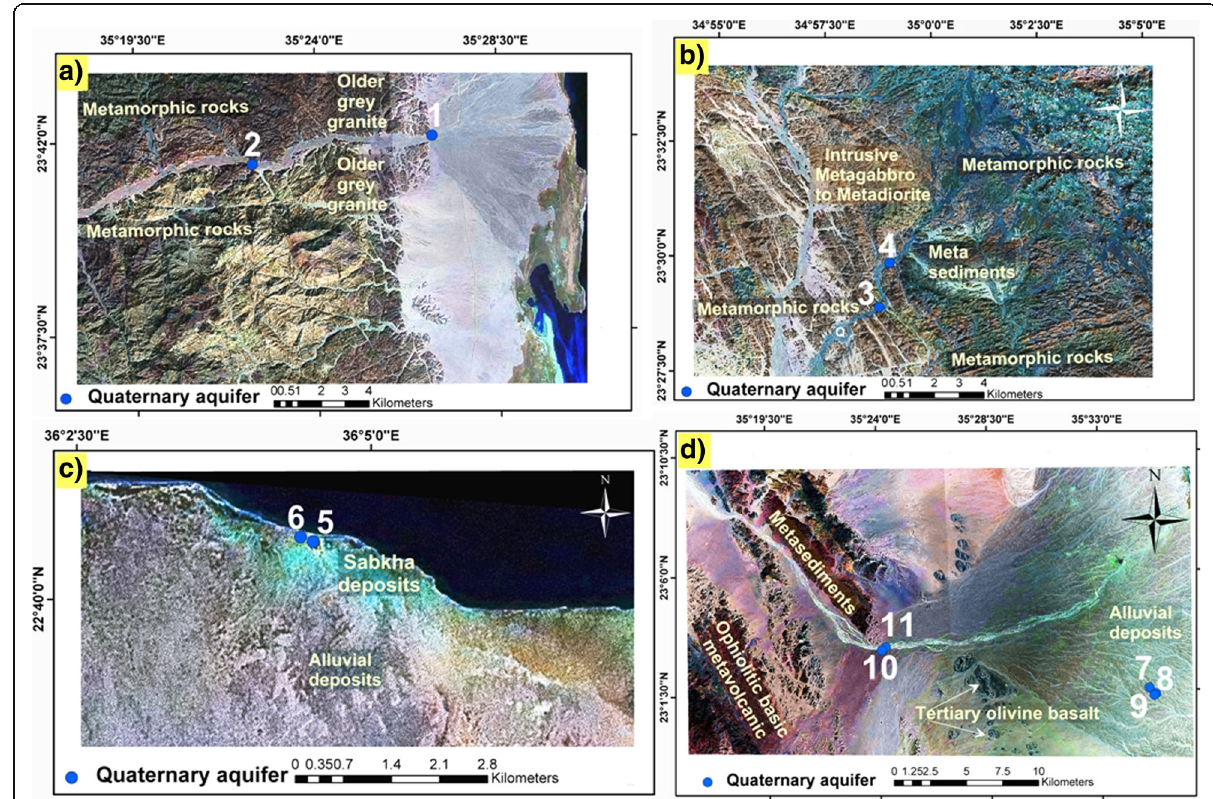
Fig. 4 Wells location map of alluvial Quaternary aquifer illustrated on Landsat images (GeoCover ETM+ 2010). a – d The geology along the flow path which affected the groundwater